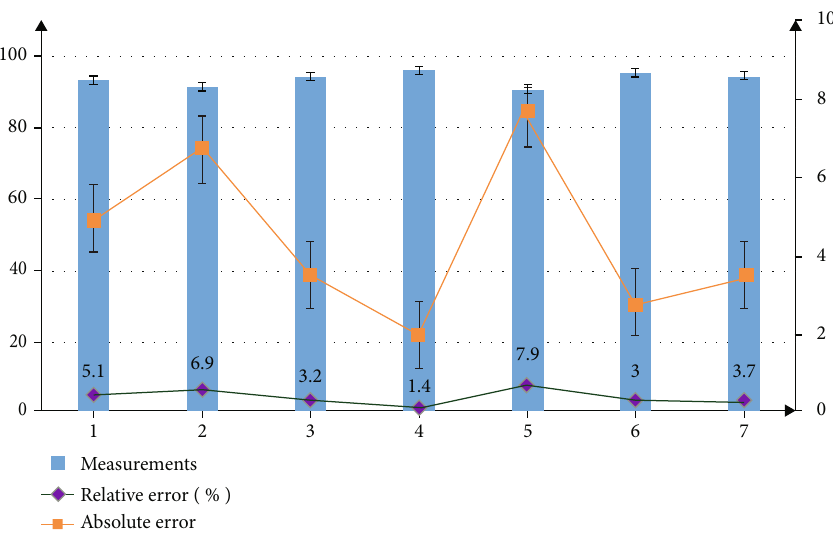
Figure 5: Accuracy analysis of blood oxygen saturation